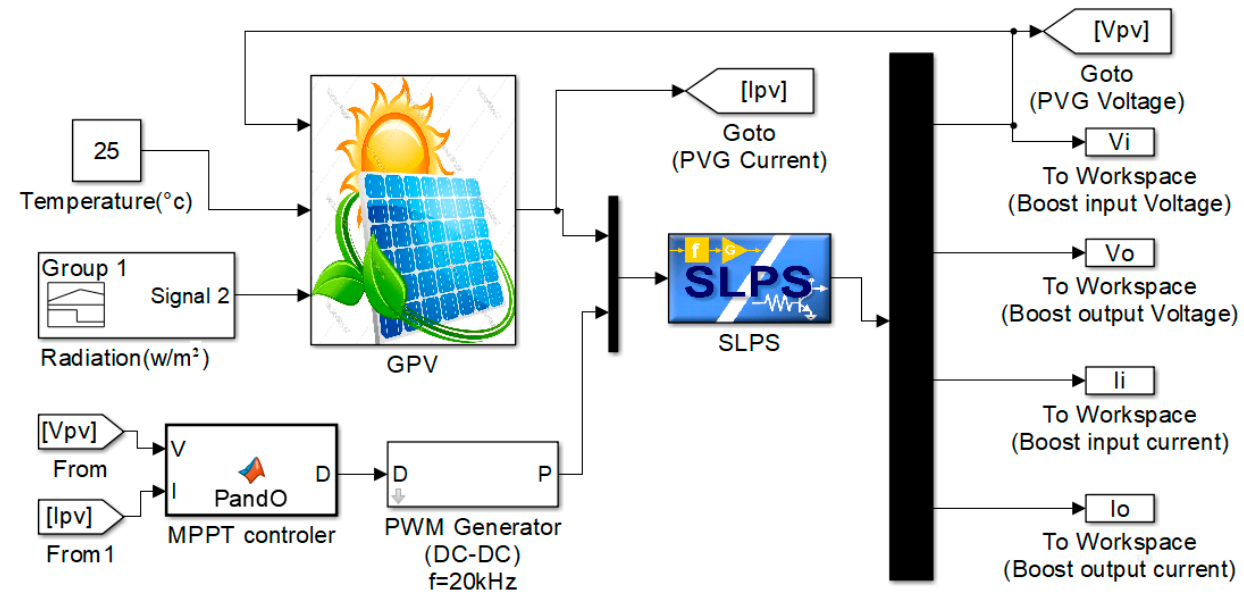
Figure 12. Simulation block diagram.